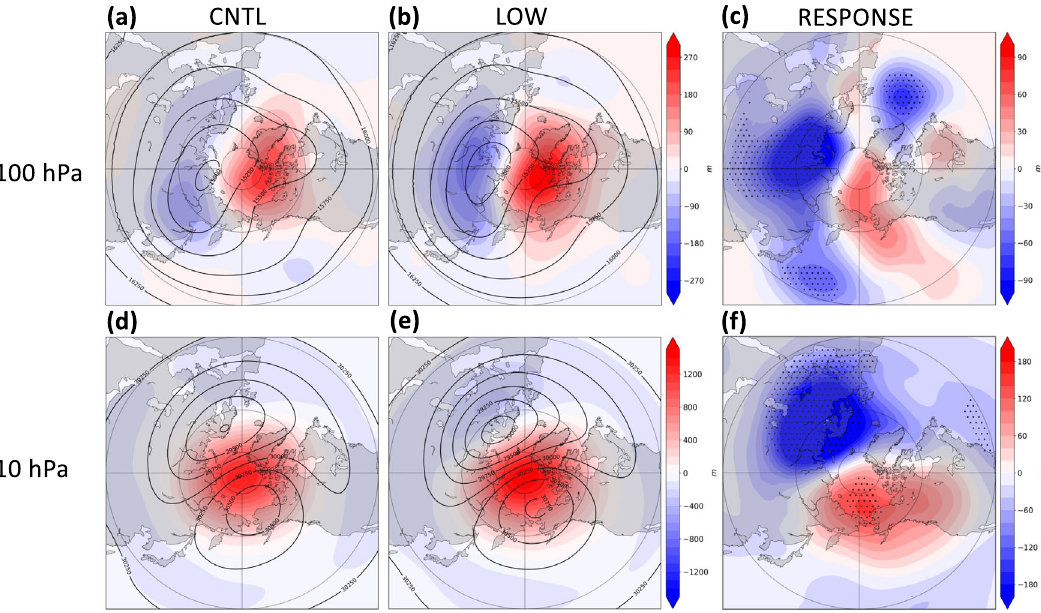
Fig. 2 Changes in the polar vortex characteristics induced by Paci fi c-sector Arctic sea ice loss. Composite of the 100-hPa ( a – c ) and 10-hPa ( d – f ) geopotential height at SSW onset (day 0). The left column corresponds to the CNTL experiment, the middle column to the LOW experiment, and the right column to the response to sea ice loss (i.e., LOW-CNTL). Line and fi lled contours are total fi eld and anomaly (de fi ned as the departure from climatology), respectively, in ( a , b , d , e ). Stippling in ( c , f ) indicates statistical signi fi cance at the 95% level in the